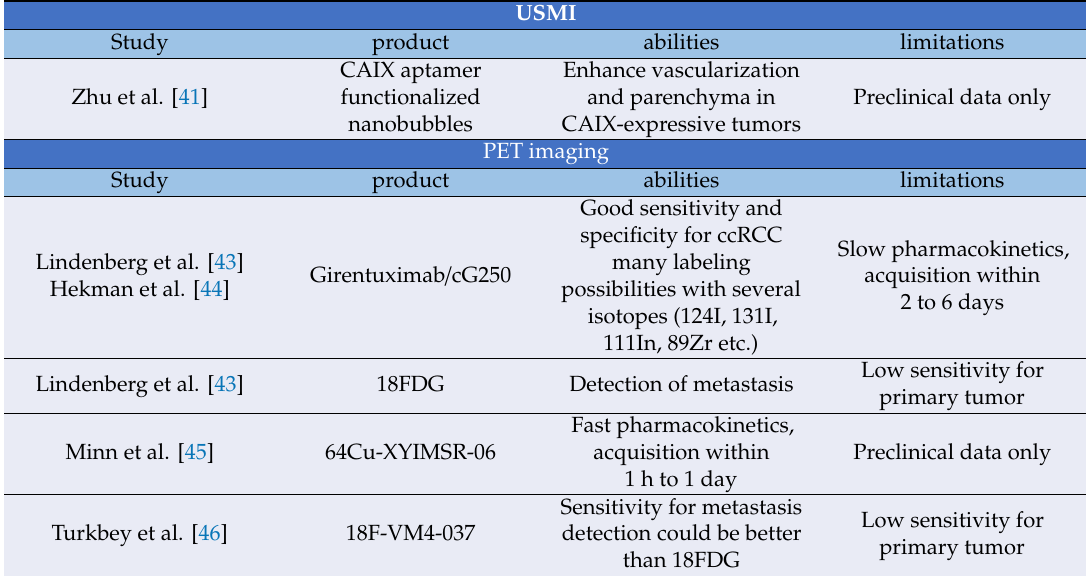
Table 2. Evidence synthesis of CAIX application for molecular